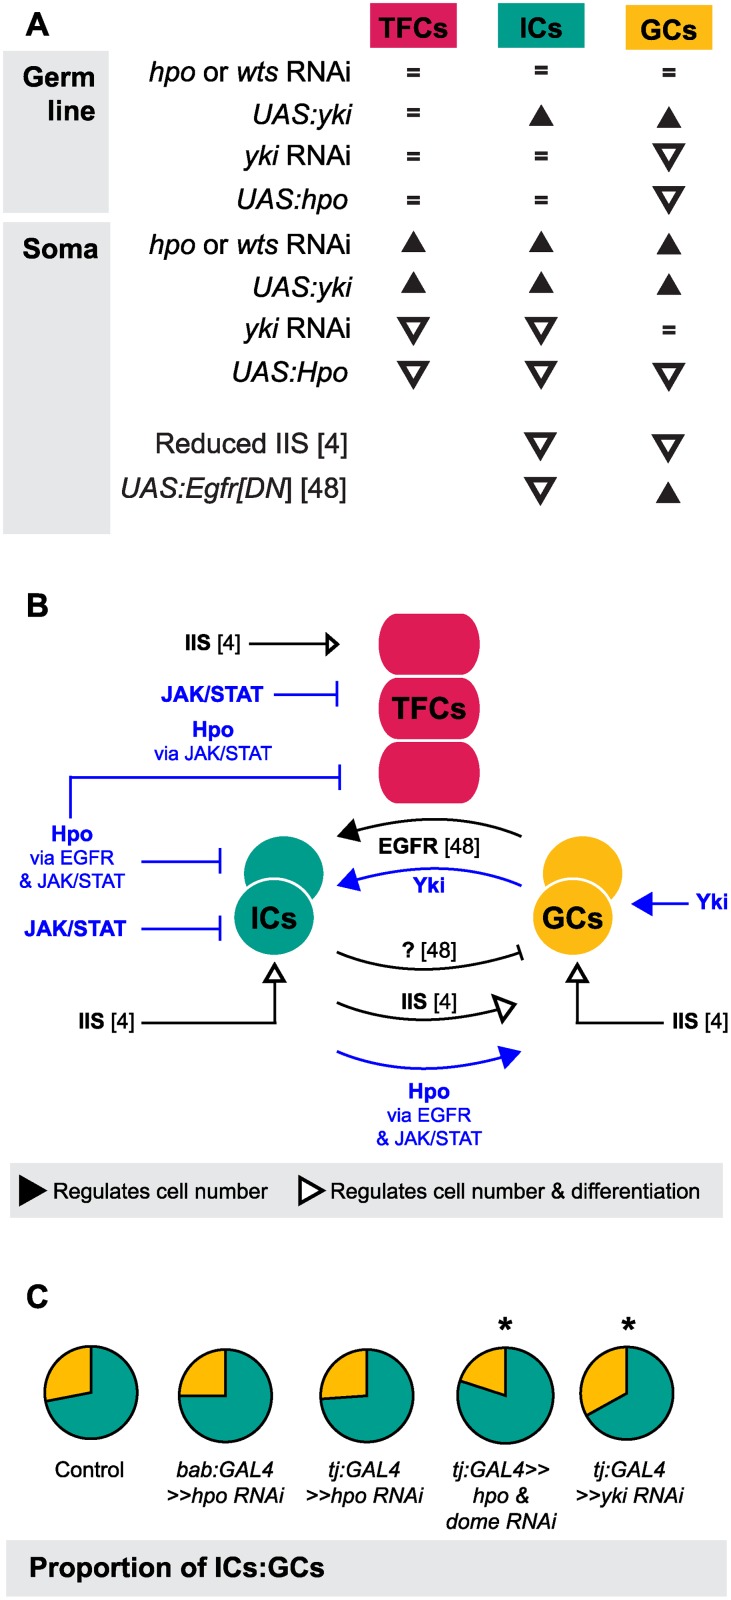
The Hippo pathway regulates coordinated growth of the soma and germ line.(A) Summary of changes in TFC, IC and GC numbers when expression of genes from various growth pathways were altered in our study and two other studies [6,49]. Black triangles indicate significant increase; white triangles indicate significant decrease; = indicate no significant change. (B) Model of how Hippo pathway influences coordinated proliferation of somatic cells and germ cells in the larval ovary. Contributions of the present study are indicated in blue; elements of the model derived from other studies [6,49] are indicated in black. The Hippo pathway interacts with JAK/STAT to regulate proliferation of TFCs, and interacts with EGFR and JAK/STAT pathways to regulate autonomous proliferation of ICs and non-autonomous proliferation of GCs. In addition, yki acts independently of hpo to influence proliferation of GCs in a non-canonical manner. (C) Summary of representative IC (green)/GC (yellow) proportions observed in our experiments, further elaborated in S7 Fig. Proportions of ICs and GCs are similar to controls when we knock down hpo or wts alone in the soma, but disrupting both hpo and EGFR or JAK/STAT pathway members leads to loss of proportional growth. Asterisk denotes p<0.05. See S6 Table for numerical values.